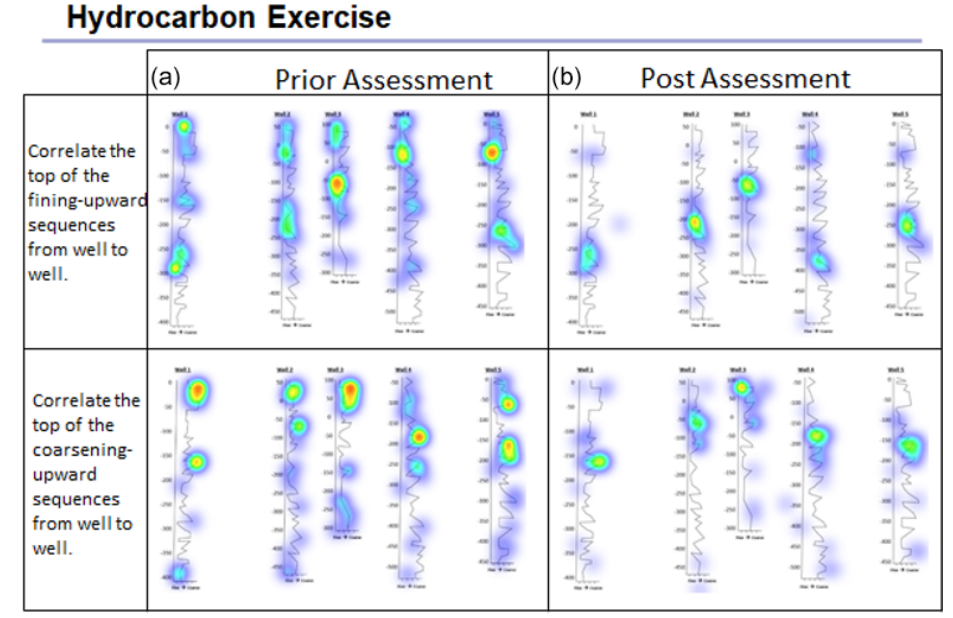
Figure 3. An example heatmap question from the pre-survey (a) and post-survey (b) illustrating the improvement of students’ ability to select the correct location of sedimentary features from a geophysical well log. Note that the post-survey indicated more targeted answers than the pre-survey.